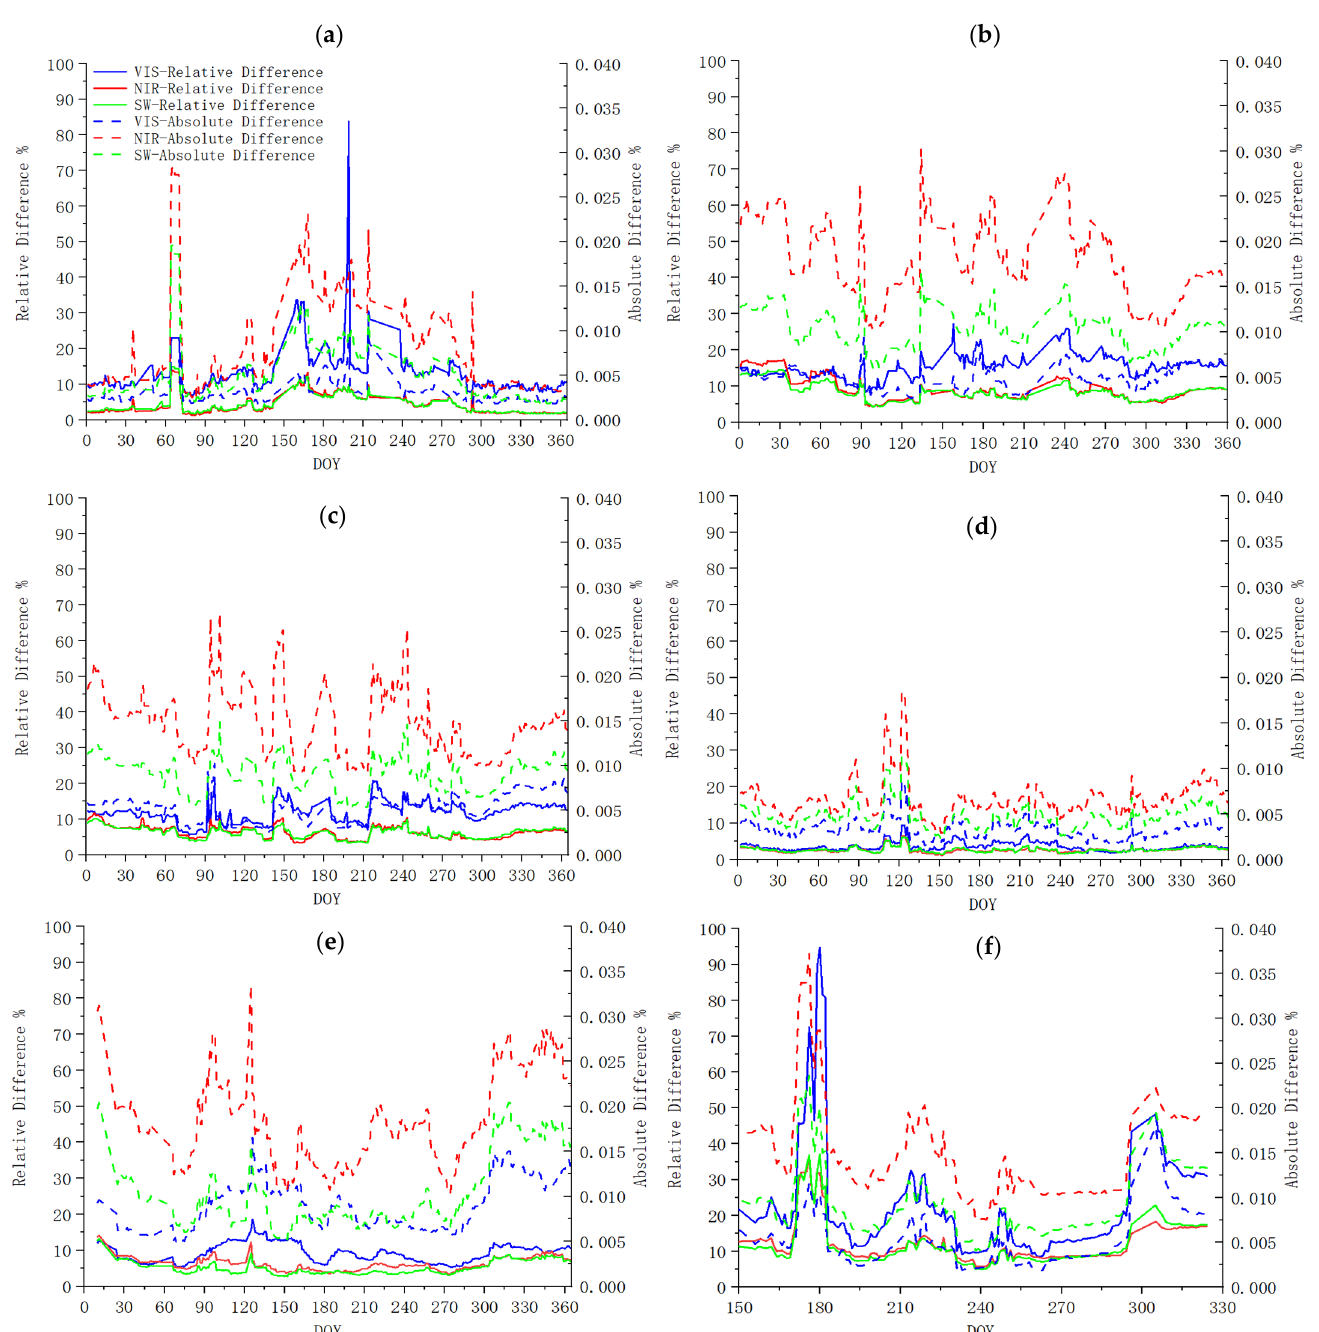
Figure 13. Daily variation curves of albedo due to BRDF spatial smoothing in three broad bands for each selected EBF ( a ), DBF ( b ), Savanna ( c ), Grassland ( d ), Cropland ( e ), and ENF ( f ) site.